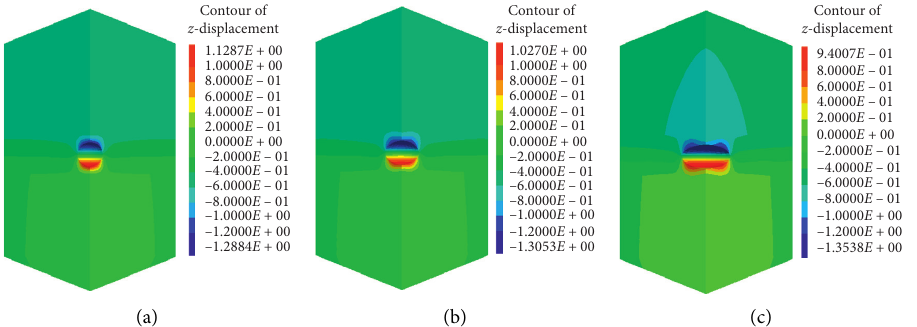
Figure 5: Cloud map of vertical displacement distribution of surrounding rock after operation for 20 a of salt rock storage under different diameter-to-height ratios. (a) N � 1.5; (b) N � 2.0; and (c) N �